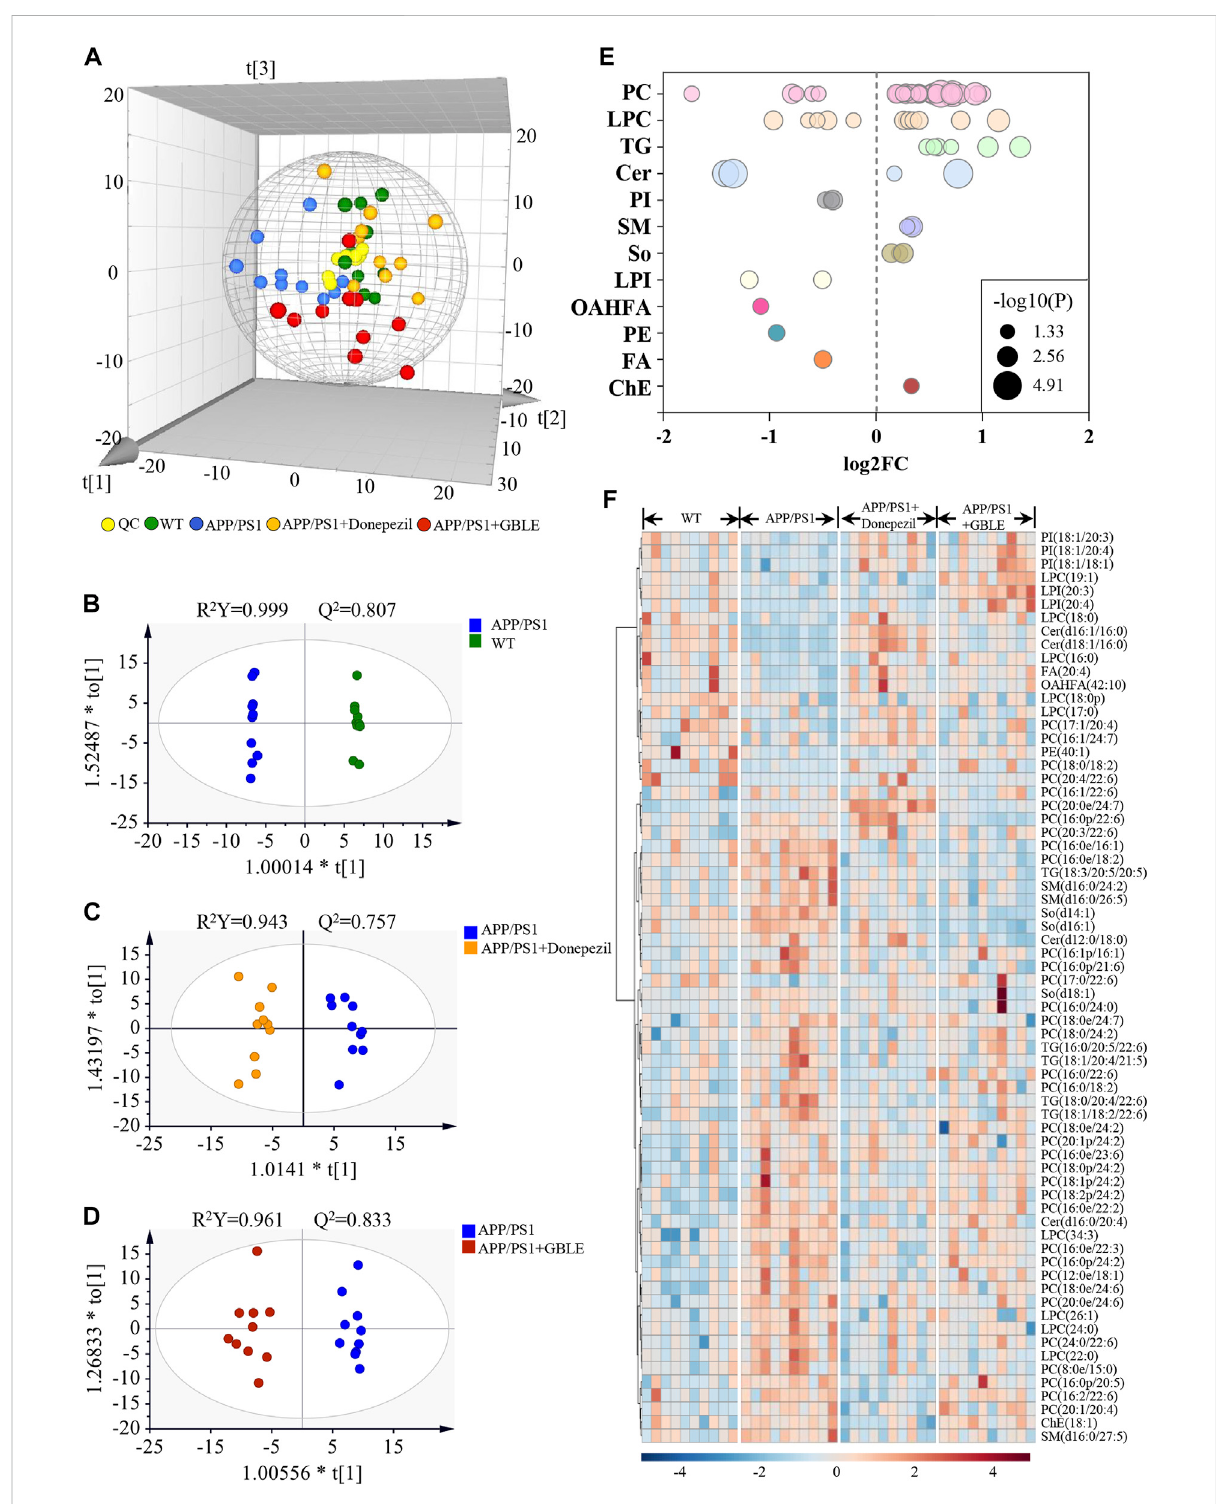
UHPLC-Q-Orbitrap HRMS-based lipidomicanalysis .(A) ThreedimensionalPCA plotofall the plasmasamplesfrom differentgroups. (B) OPLS- DA score plot for APP/PS1 vs. WT group. (C) OPLS-DA score plot for APP/PS1+Donepezil vs. APP/PS1 group. (D) OPLS-DA score plot for APP/ PS1+GBLE vs. APP/PS1 group. (E) Bubble chart of differential lipids for APP/PS1 vs. WT group. (F) Heatmap of the 68 differential lipids among the WT, APP/PS1, APP/PS1+Donepezil, and APP/PS1+GBLE groups. The colors from blue to red indicates the elevation of lipid